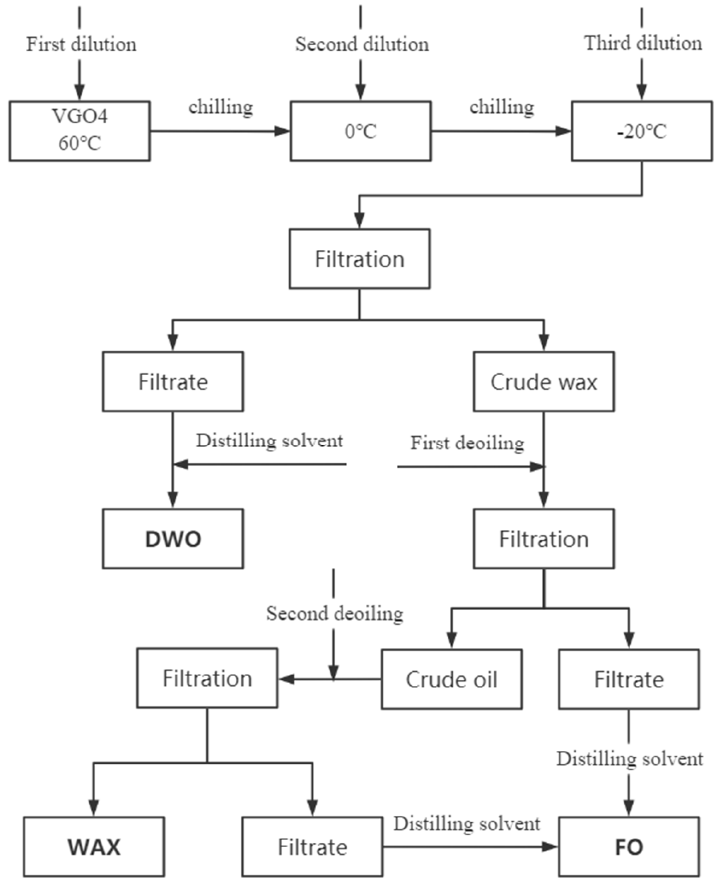
Figure 4. A diagram of the MEK–toluene dewaxing